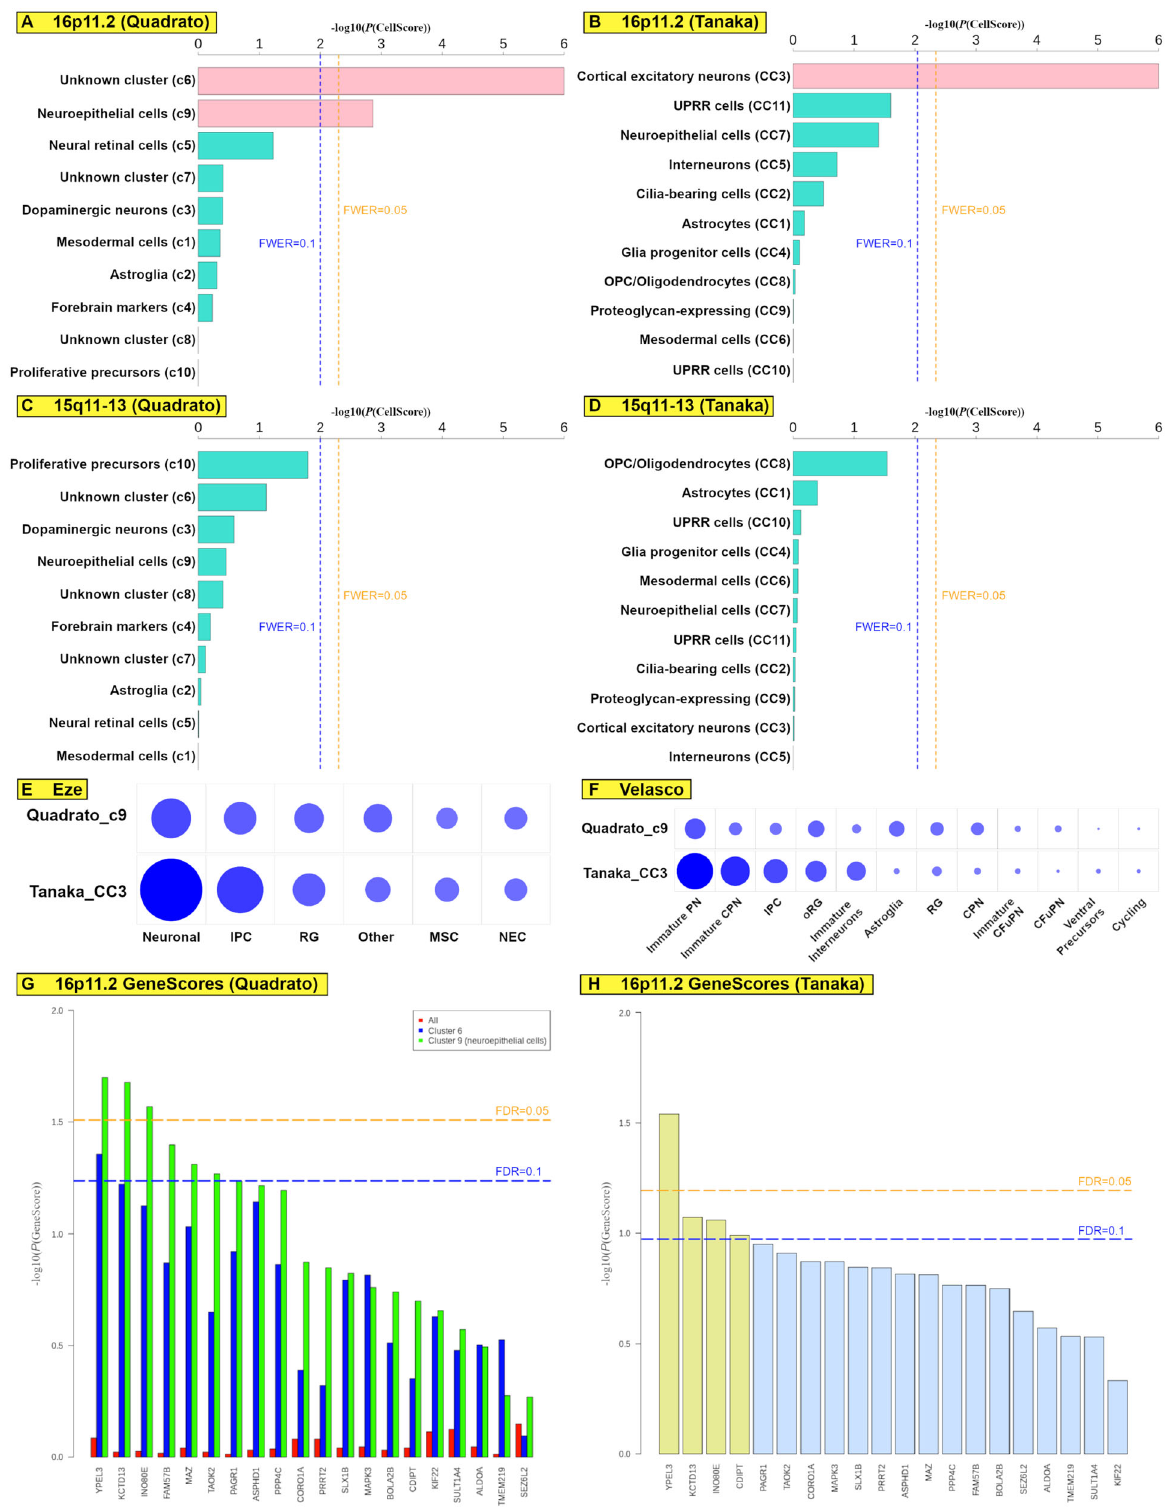
Fig. 3 Prioritized critical cell types for the 16p11.2 and 15q11-13 loci. All data were analyzed from 71 bRNA-seq samples across 25 donors. A CellScore results with one-sided tests for 16p11.2 (Quadrato dataset 1 ); clusters with FWER ≤ 0.1 in pink adjusted for multiple comparisons. B CellScore results with one-sided tests for 16p11.2 (Tanaka dataset 19 ); clusters with FWER ≤ 0.1 in pink adjusted for multiple comparisons. C CellScore results with one-sided tests for 15q11 – 13 (Quadrato dataset 1 ). D CellScore results with one-sided tests for 15q11 – 13 (Tanaka dataset 19 ). E Fine-mapping identities of critical cell types for 16p11.2 (Eze dataset 20 ); sizes of the circles represent mean gene overlaps between cell type clusters. F Fine-mapping identities of critical cell types for 16p11.2 (Velasco dataset 13 ); sizes of the circles represent mean gene overlaps between cell type clusters. G GeneScore results for 16p11.2 (Quadrato dataset 1 ). H GeneScore results for 16p11.2 (Tanaka dataset 19